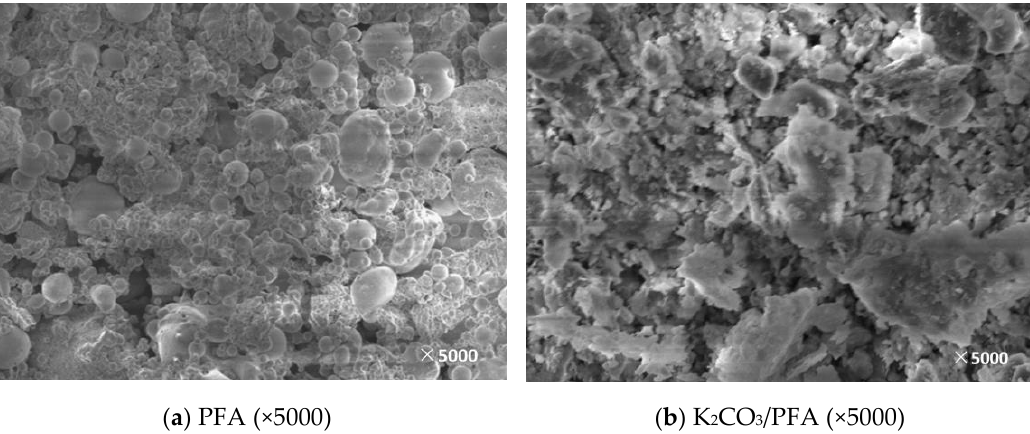
Figure 9. SEM image before and after PFA loading. ( a ): The SEM image of PFA; ( b ): The SEM image of K 2 CO 3 /PFA.